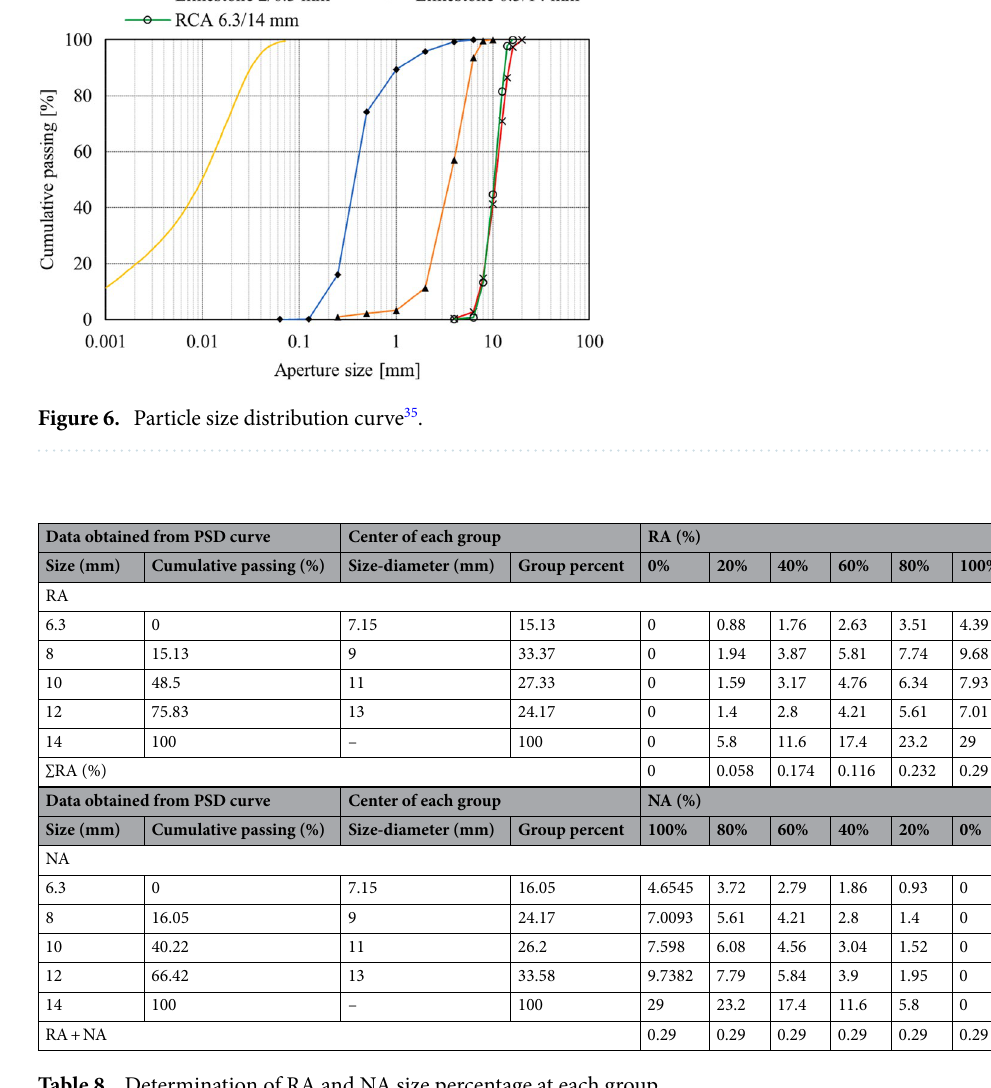
Table 8. Determination of RA and NA size percentage at each group.